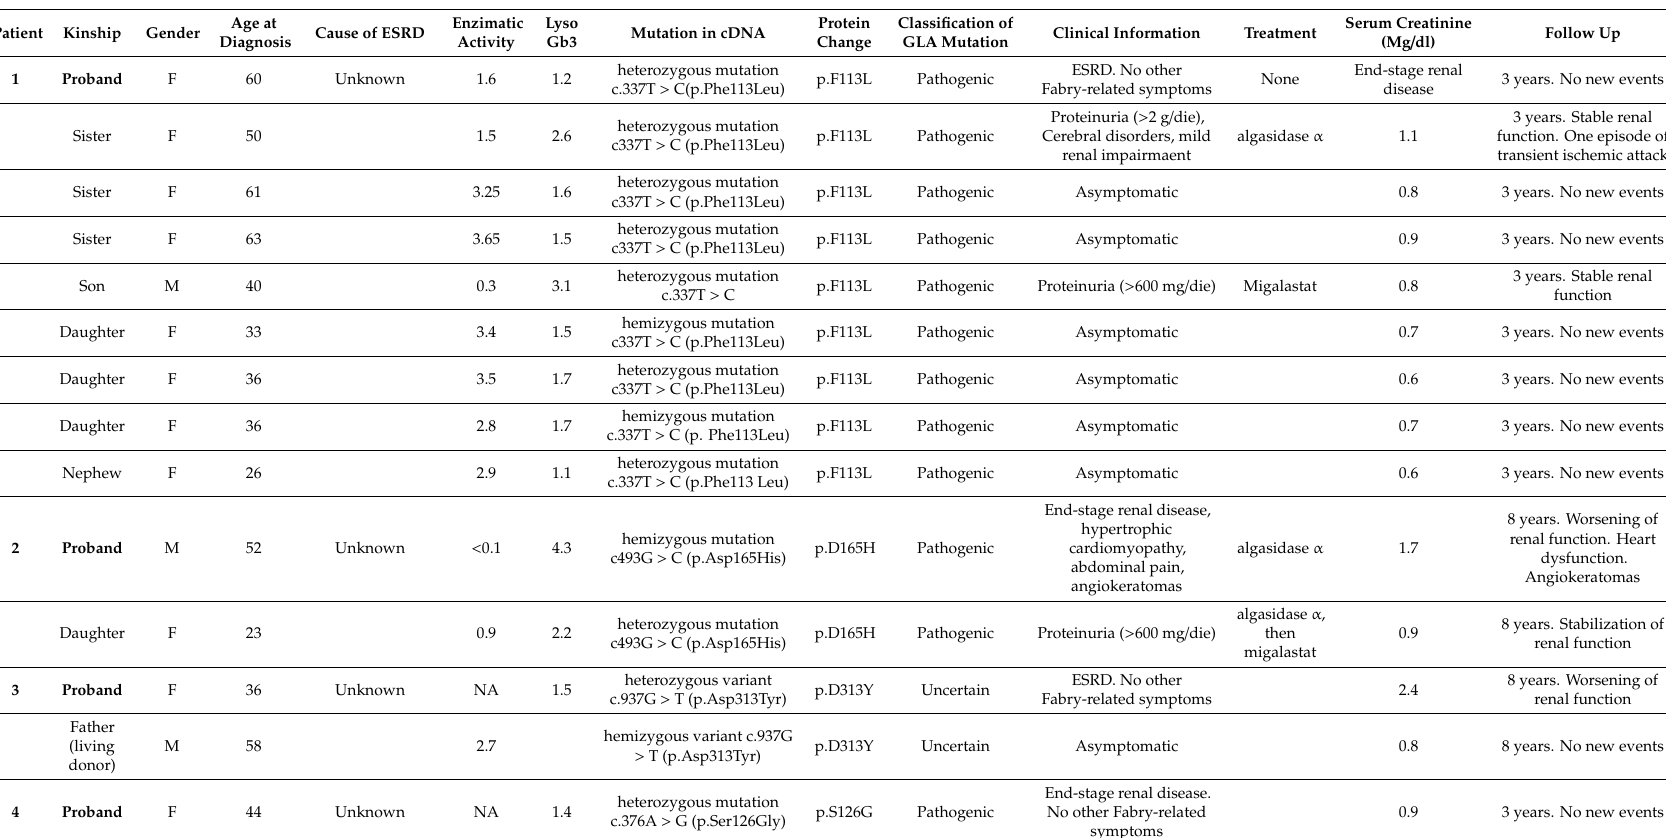
Table 2. Clinical and molecular information of the proband and relatives with mutation in α -galactosidase A (GLA). Normal values of α -galactosidase A activity assayed in whole blood are > 2.6 µ mol / l / h. Normal values of lyso-Gb3 are < 1.8 ng / mL. The cause of end-stage renal disease refers only to kidney transplant recipients